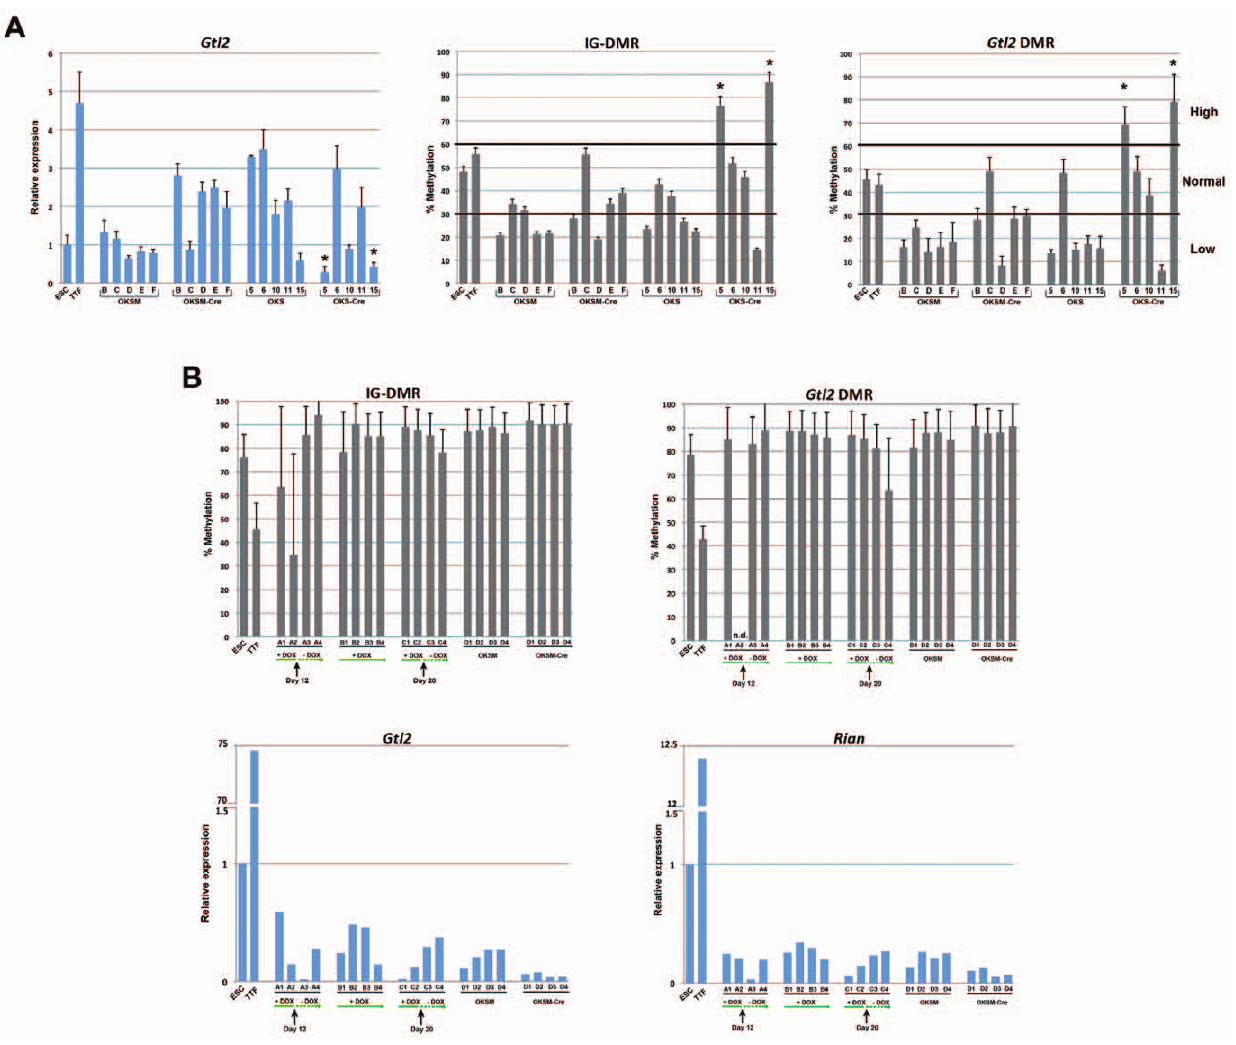
Figure 2. Epigenetic status and transcriptional activity of the Gtl2 locus in iPSC lines generated with STEMCCA. (A) Gtl2 transcript levels were estimated by qRT-PCR in the starting cell population (TTFs), ESCs, and the 20 iPSC clones profiled by microarray. The percentage of methylated CpG dinucleotides in the Gtl2 IG-DMR and Gtl2 DMR were determined by pyrosequencing of sodium bisulfite-treated genomic DNA. Asterisks indicate Gtl2 OFF iPSC clones. (B) Twenty additional iPSC clones were derived from TTFs isolated from a different mouse strain (C57BL/6), using either the Doxycycline (Dox)-inducible or the constitutive STEMCCA vector and analyzed as in (A). Doxycycline was withdrawn at the indicated time points or kept throughout the expansion of iPSCs. n.d.: not detected.